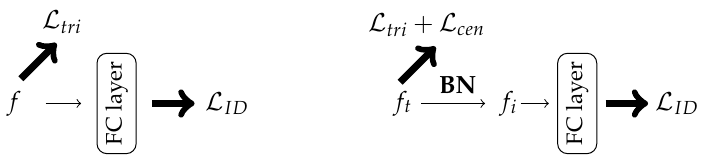
Figure 7. The pipeline of the standard baseline ( right ) and the proposed BNNeck [98]. Algorithm 2: PyTorch-style command for